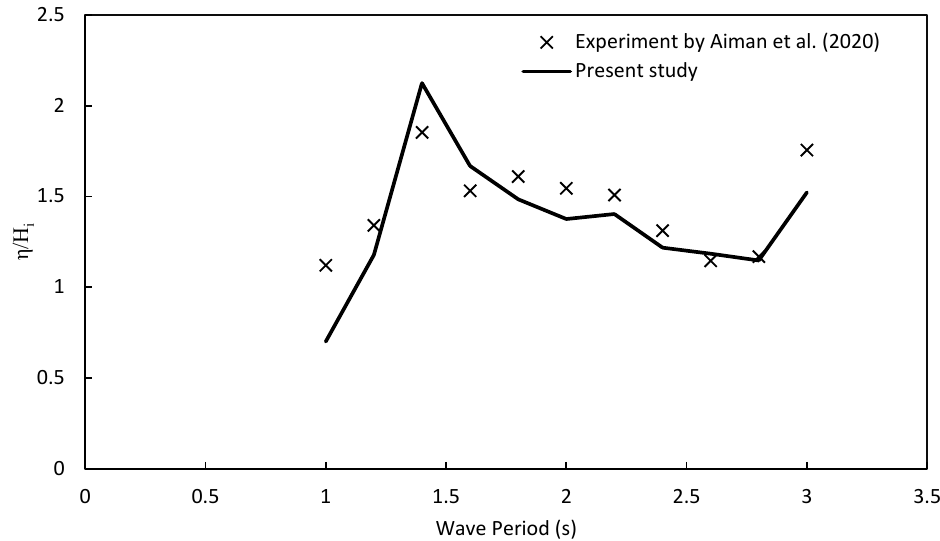
Figure 9. Wave Elevation Inside the BBDB Water Column [22].